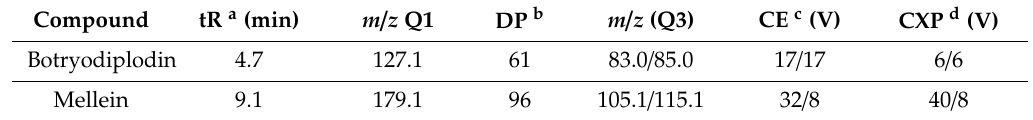
Table 1. LC-MS / MS parameters for botryodiplodin and